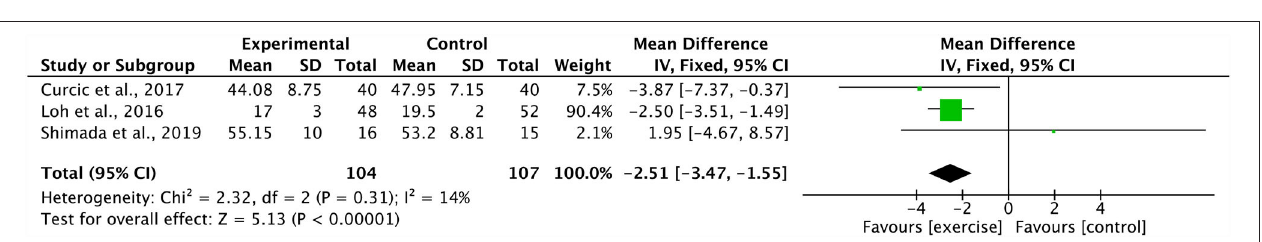
FIGURE 4 | The effects of aerobic training on PANSS general scores.